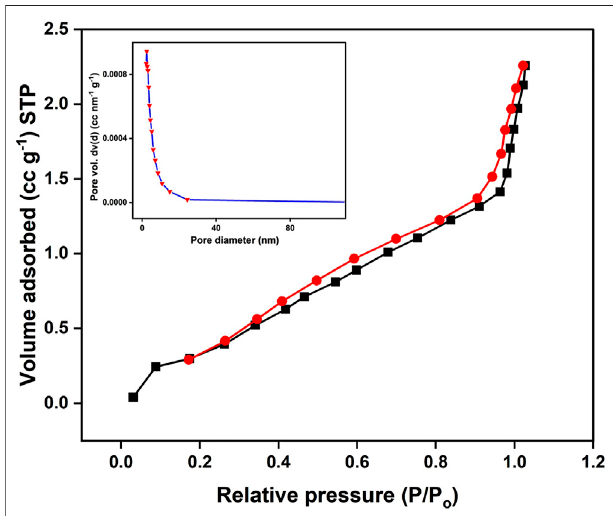
FIGURE 3 | Representative SEM images of catalyst OP-SO 3 H-4 at various magni fi cations (A – C) . EDS mapping of Sulfur (D) , SEM images from where elemental mapping was analyzed, and SEM-EDS elemental mapping (F) of the area in the red box in (E) .